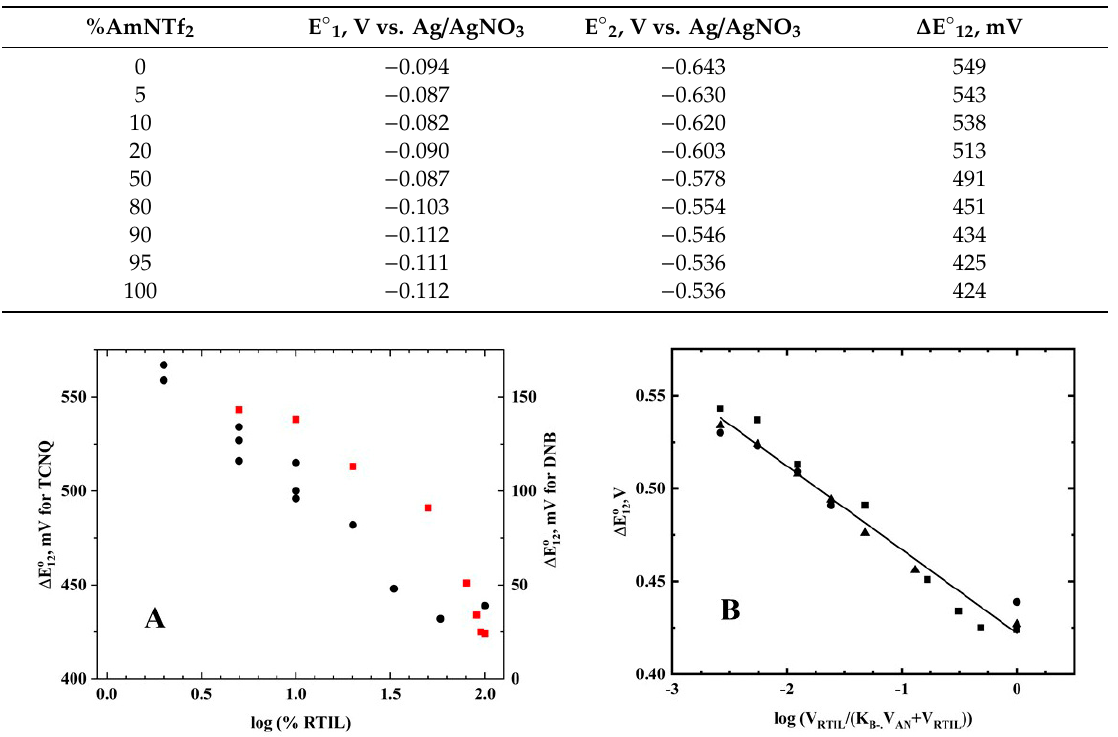
Figure 3. ( A ) ∆ E ◦ 12 values for TCNQ (red) and 1,4-dinitrobenzene (black) in acetonitrile / AmNTf 2 mixtures as a function of log (%RTIL). Dinitrobenzene data from Reference [2]. ( B ) ∆ E ◦ 12 values for TCNQ in acetonitrile / RTIL mixtures as a function of Equation (3). ( ν ) AmNTf 2 ; ( (cid:8) ) BMImPF 6 ; ( (cid:78) ) BMImBF 4 . Electrolyte in acetonitrile and mixed acetonitrile / RTIL solutions: 0.10 M TBAP.